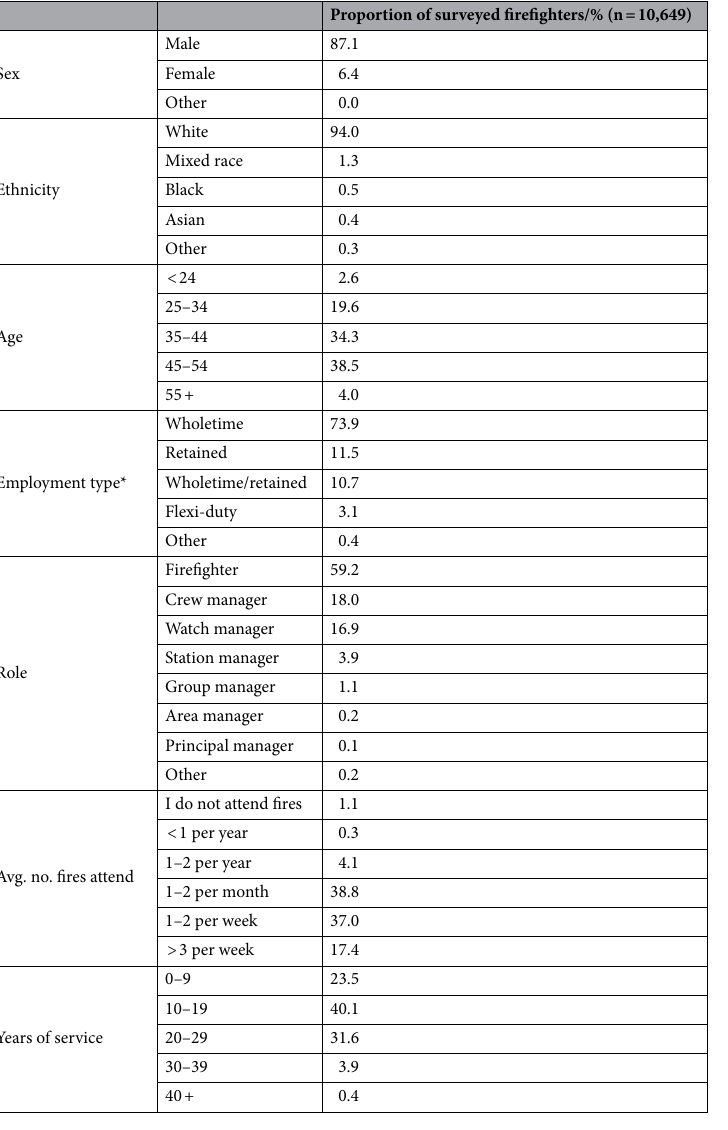
Table 1. Participant Demographics. The proportion of total surveyed firefighters belonging to each demographic category. *Wholetime firefighters work full-time contracted hours/shift patterns. Retained firefighters do not have contracted hours but are kept on a paid “retainer” contract, remaining on-call for emergencies. Wholetime/retained firefighters represent wholetime firefighters who work a second retained contract outside of wholetime hours. Flexi-duty firefighters work full-time contracted hours in a more flexible shift